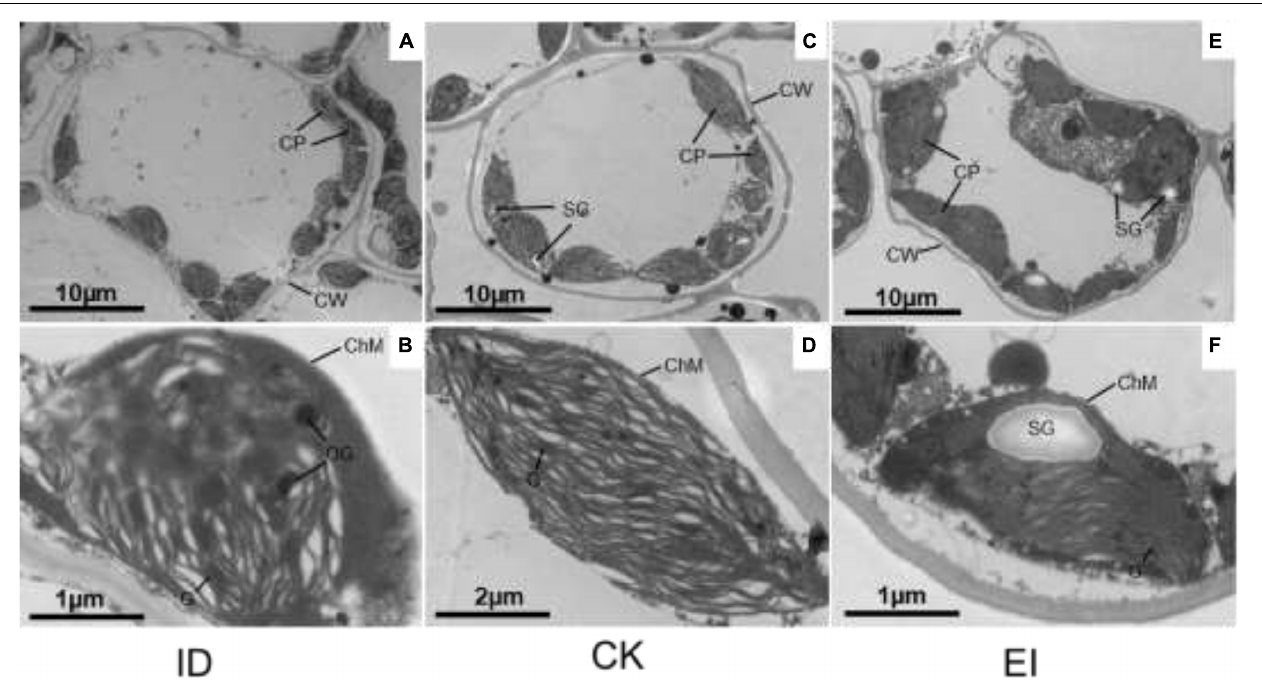
FIGURE 2 | Chloroplast structures in ID, CK and EI leaves of A. catechu . (A,B) chloroplasts in ID leaf cells; (C,D) chloroplasts in CK leaf cells; (E,F) chloroplasts in EI leaf cells; CW, Cell wall; CP, Chloroplast; ChM, Chloroplast membrane; OG, Osmiophilic granule; SG, Starch grains.